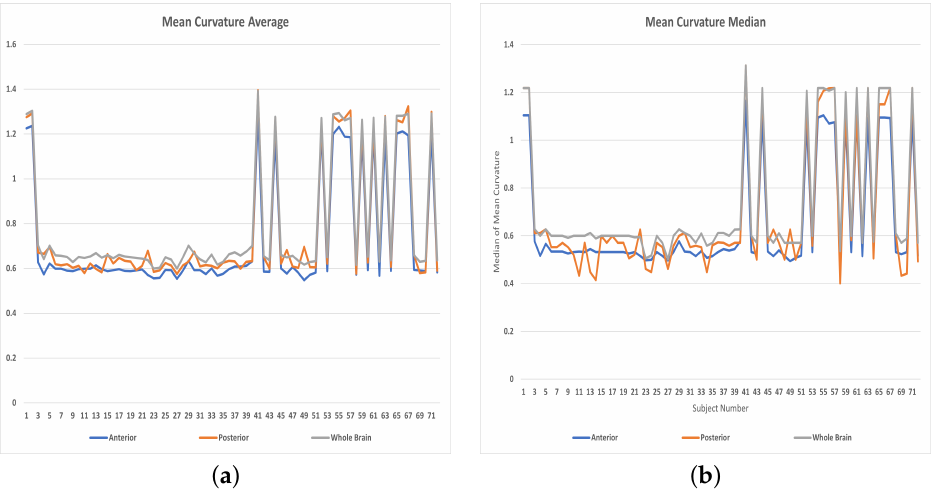
Figure 8. Features distributions: ( a ) Averages of Mean curvatures, ( b ) Medians of Mean